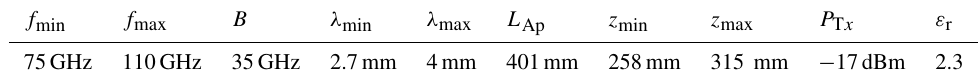
Table 1. Measurement parameters.